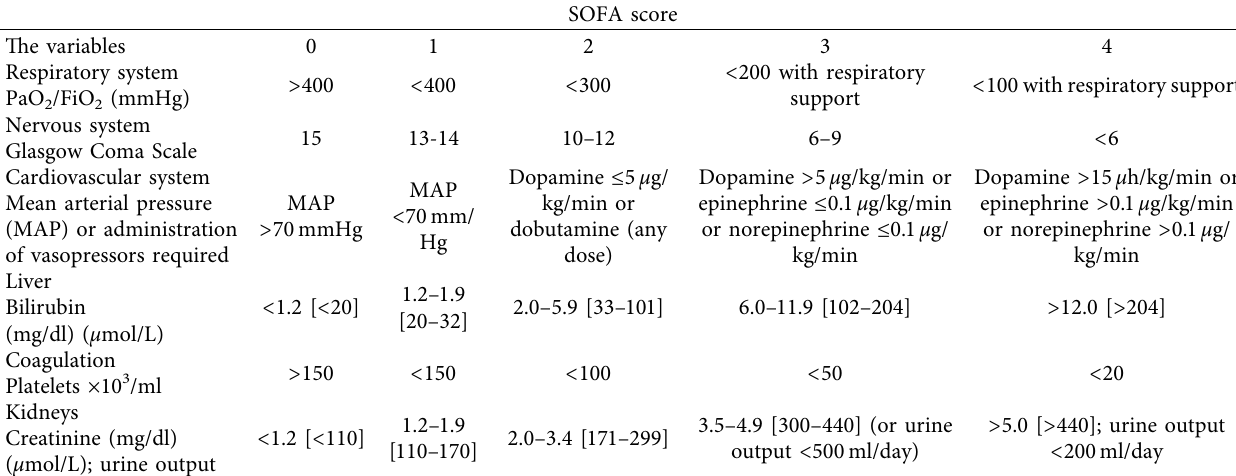
Table 1: Criteria of the sequential organ failure assessment (SOFA) score